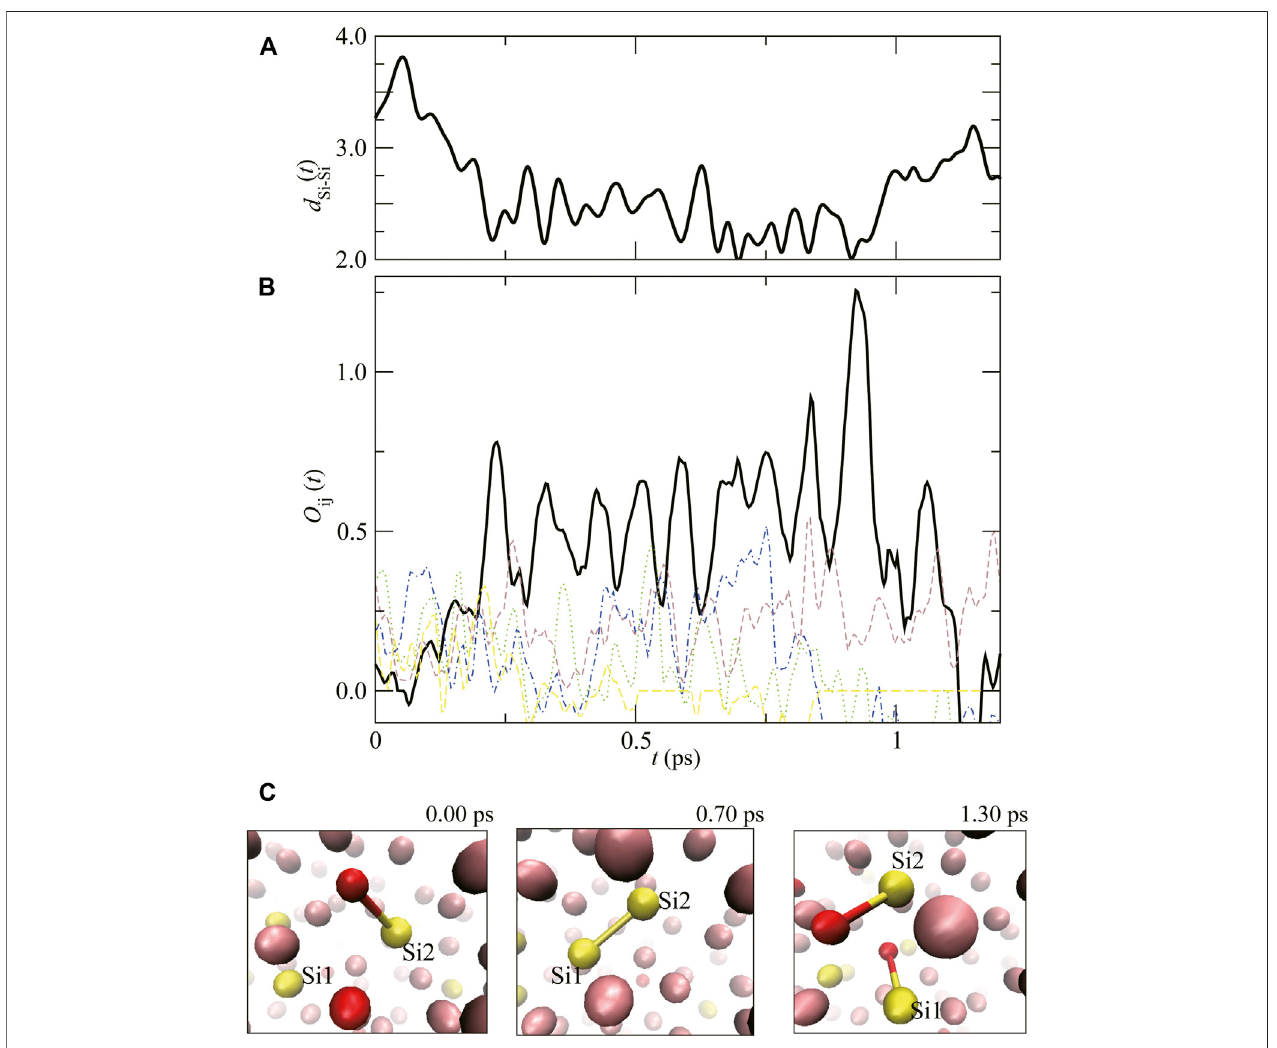
FIGURE5|(A) ThetimeevolutionofatomicdistancebetweenSi1andSi2, d Si1 – Si2 ( t ),and (B) theoverlappopulation, O Si1 − Si2 ( t ) (Thicksolidline).Dashedlinesshow O Si1 − Fe ( t ) . (C) Atomiccon fi gurationsaroundSi1and Si2att=0.00, 0.70and1.30 ps.Thepink, yellowand red spheres correspond toFe, Siand Oatoms,respectively.